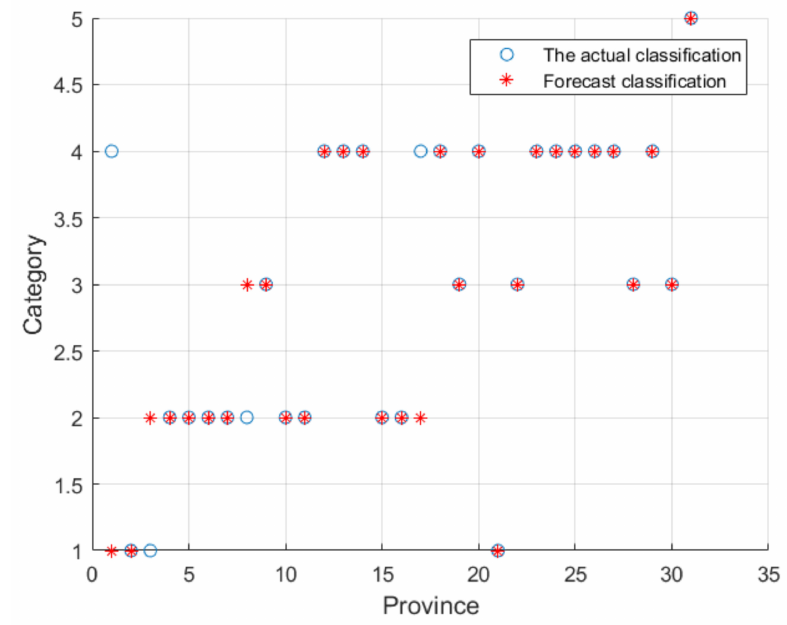
Figure 5. GA-SVM algorithm program result